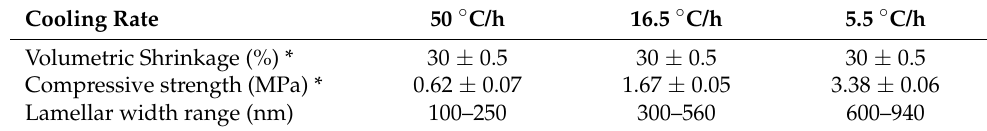
Table 1. Scaffolds’ structural parameters and compressive strength for different cooling rates.